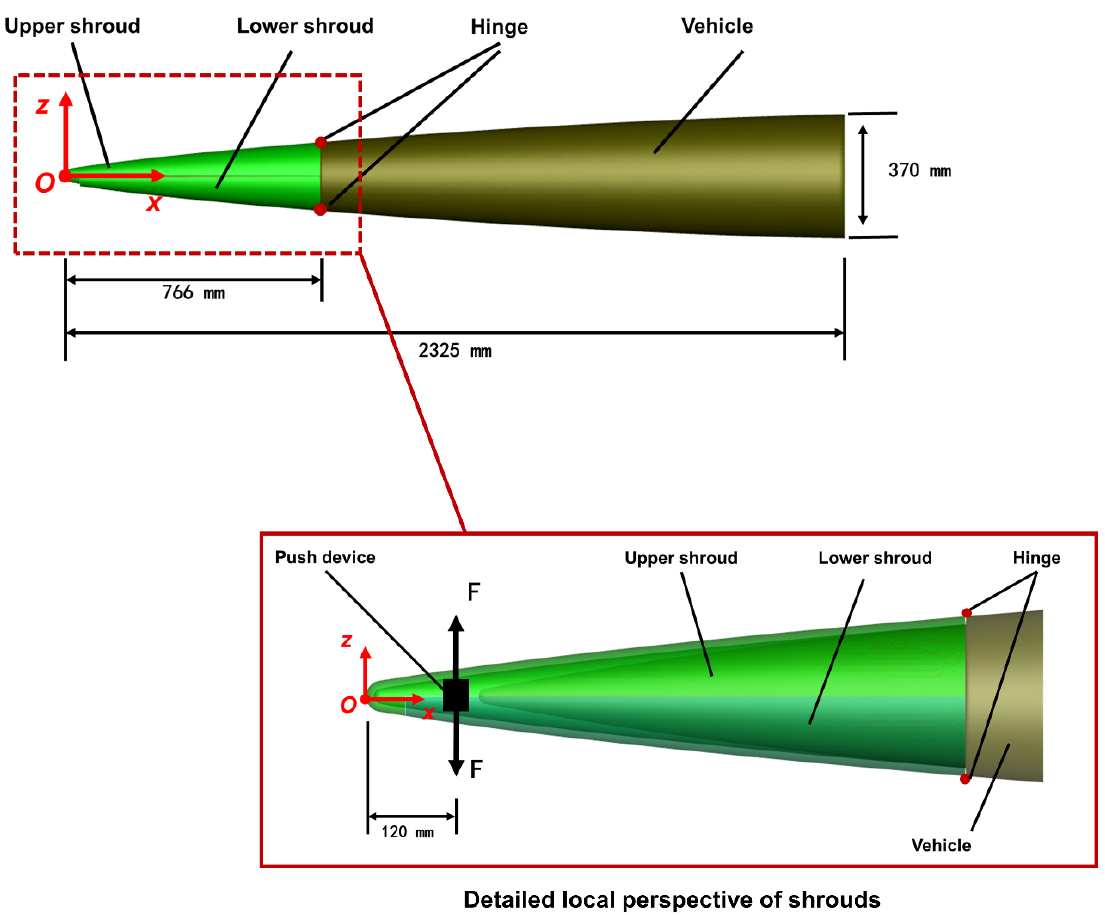
Figure 3. Basic configuration and major dimensions of the research model.